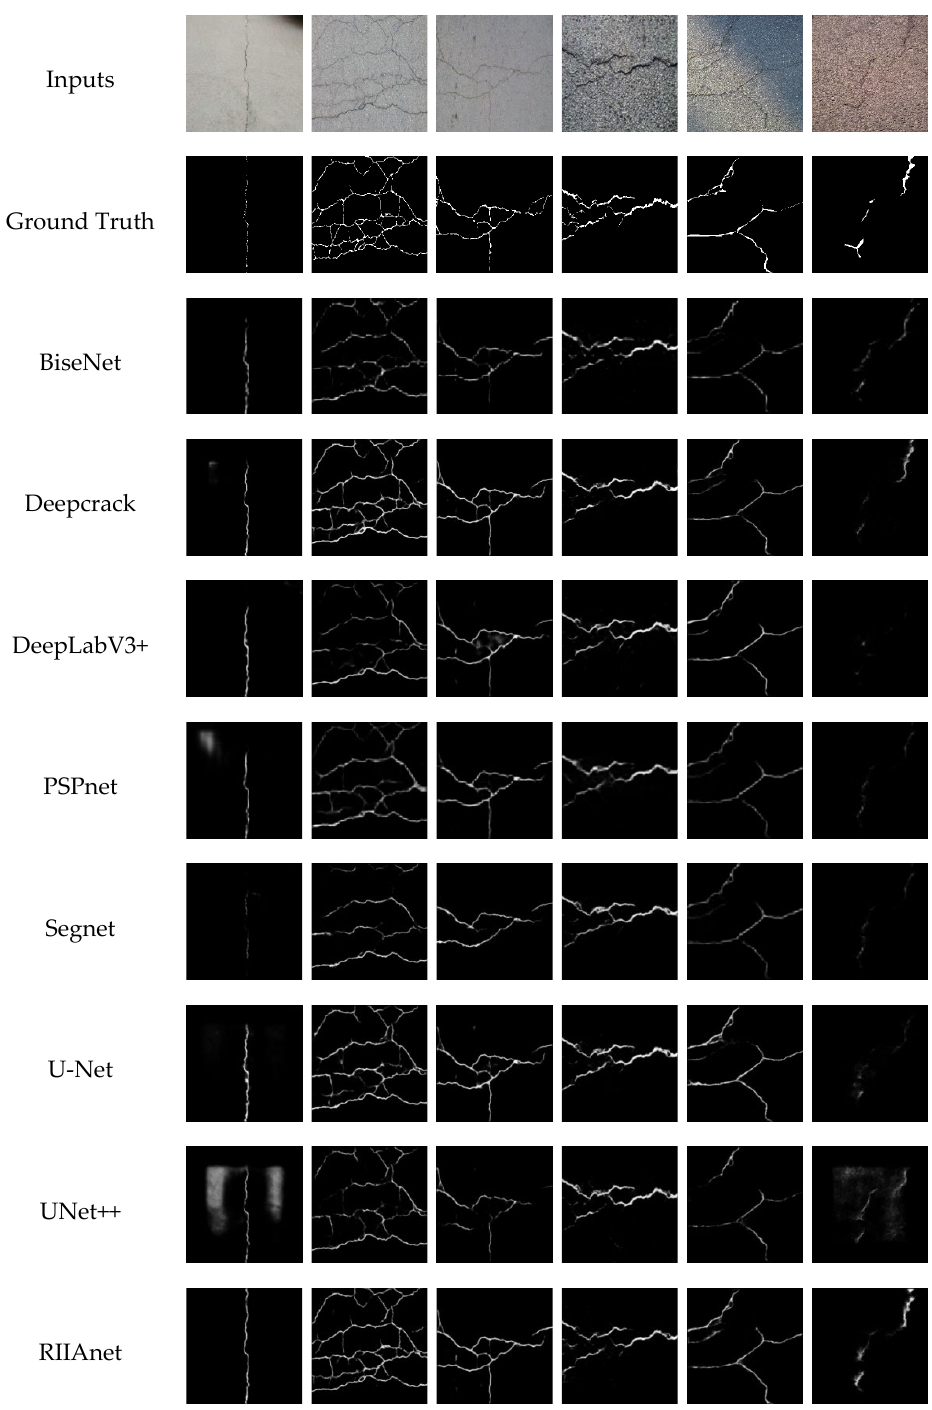
Figure 14. Comparison of the results of different methods for six selected images from the test set.